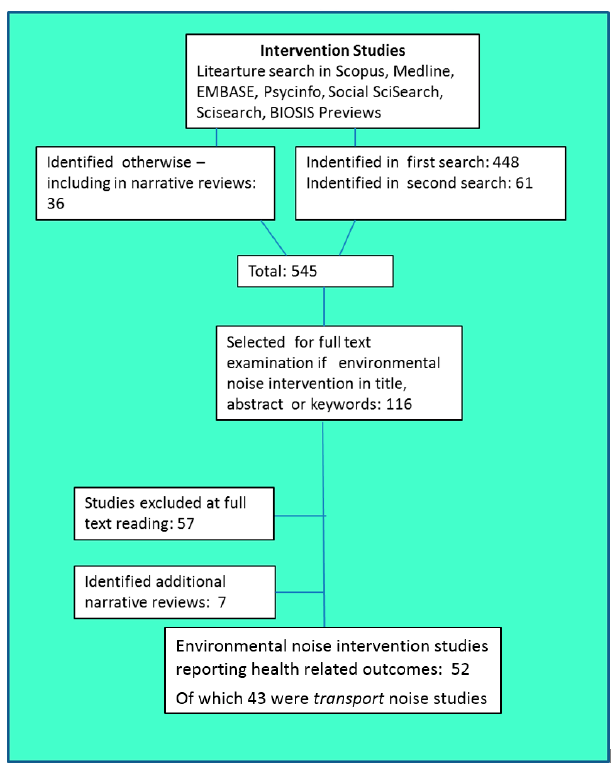
Figure 2. Flow diagram outlining the study selection process.